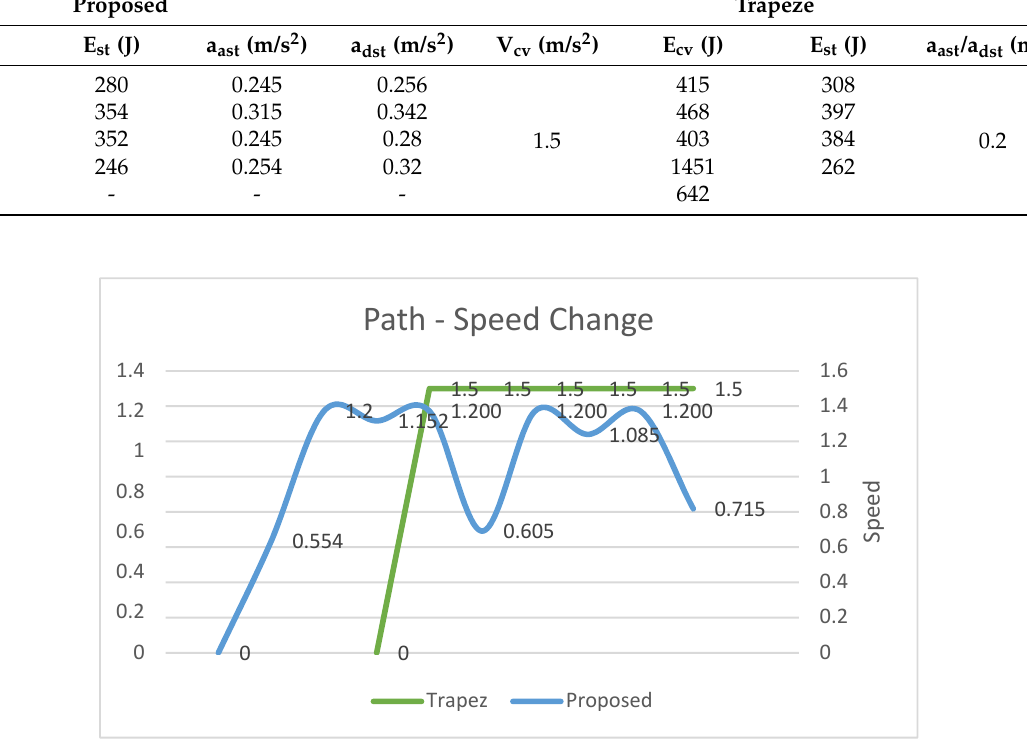
Figure 13. Proposed and Trapeze models: curved–straight path segment speed change .